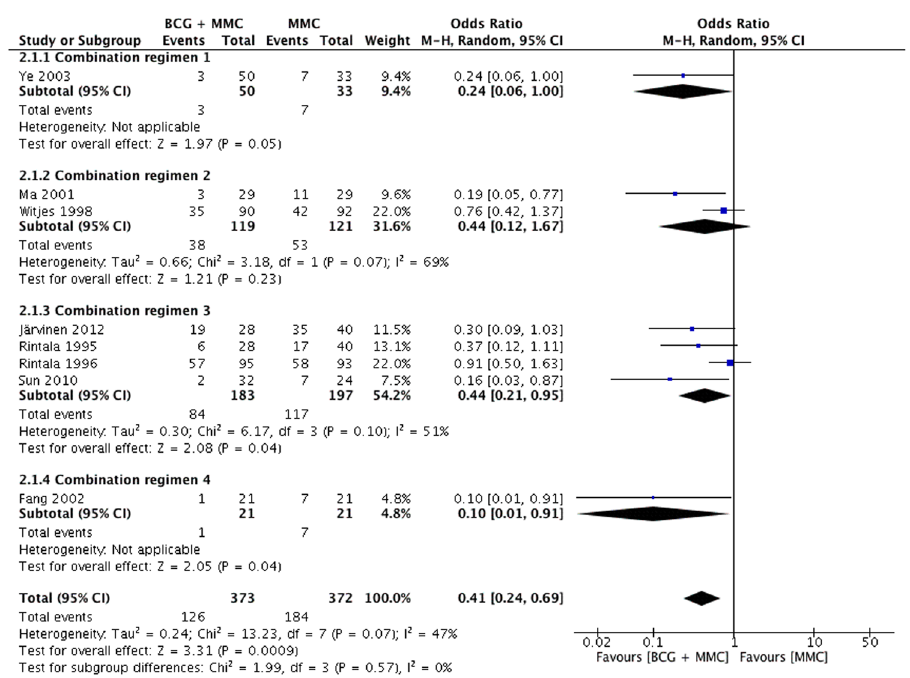
Figure 5. Forest plot of tumor recurrence rate comparing combination therapy with MMC